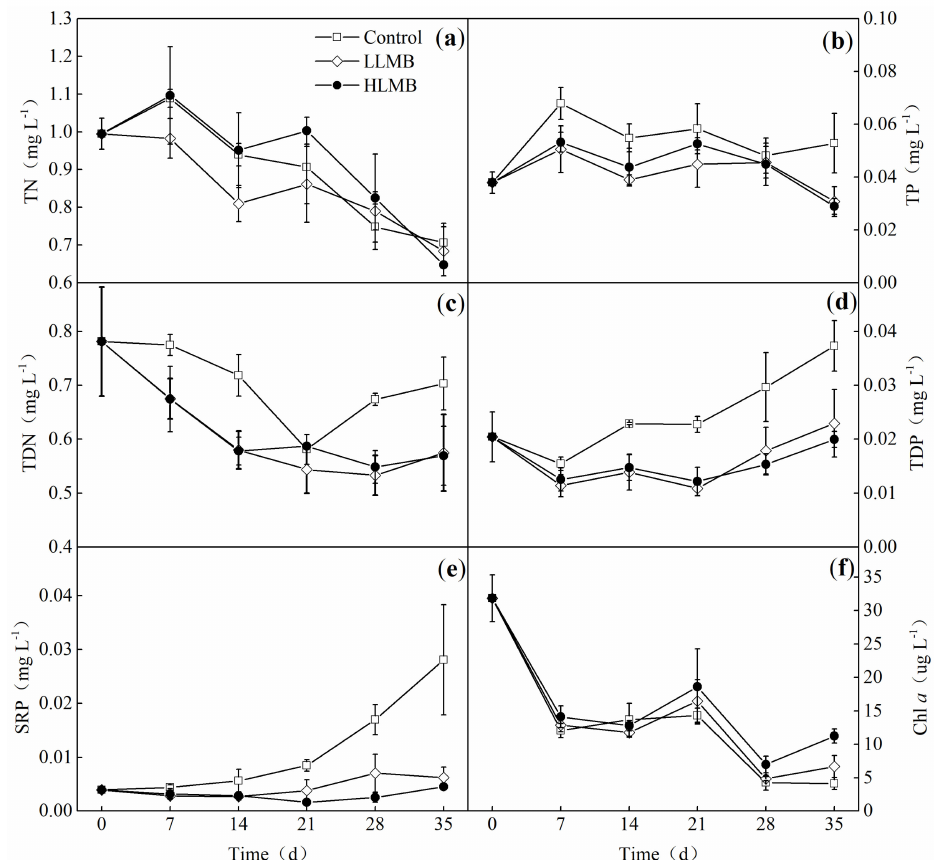
Figure 2. Time series of total nitrogen (TN) ( a ), total phosphorus (TP) ( b ), total dissolved nitrogen (TDN) ( c ), total dissolved phosphorus (TDP) ( d ), soluble reactive phosphorus (SRP) ( e ), and chloro- phyll a (Chl a ) ( f ) in different treatments. Factor was LMB (0, 425 g m − 2 , and 850 g m − 2 ). The values represented a standard deviation ( n =